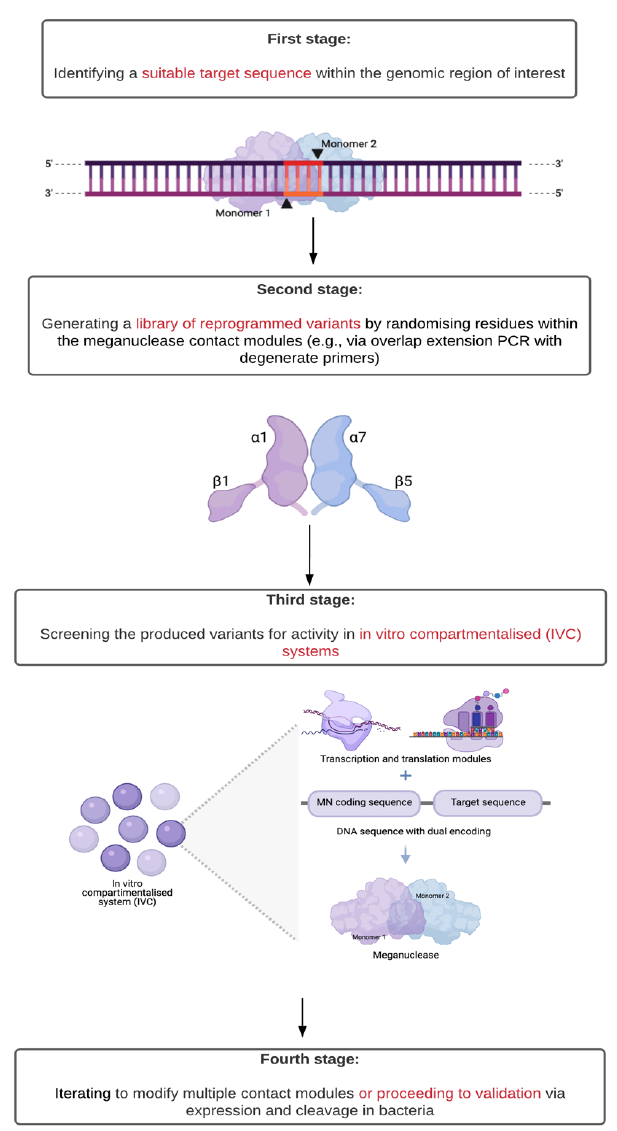
Figure 2. Workflow for reprogramming the specificity of a meganuclease (MN) [6,18]. In the first stage, the target sequence must meet two conditions: (1) contain a central four recognition motif that matches the meganuclease to be modified and (2) have a minimal number of mismatches as compared to its original recognition sequence. In the second stage, this selection minimises the number of contact modules to be modified (represented here with the distinctive structure of the MN active sites). The coupled transcription and translation capabilities of in vitro compartmentalised systems (IVC) along with sequences encoding both the meganuclease variant and its target enable high-throughput screening of activity under increasingly stringent conditions.